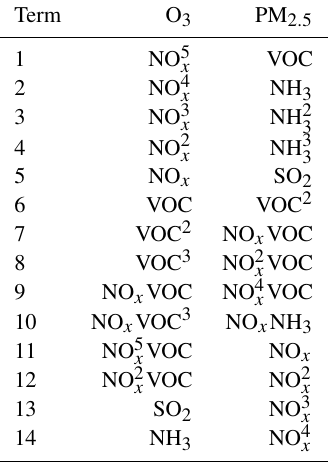
Table 1. Terms in the pf-RSM design for O 3 and PM 2 . 5 . Term O